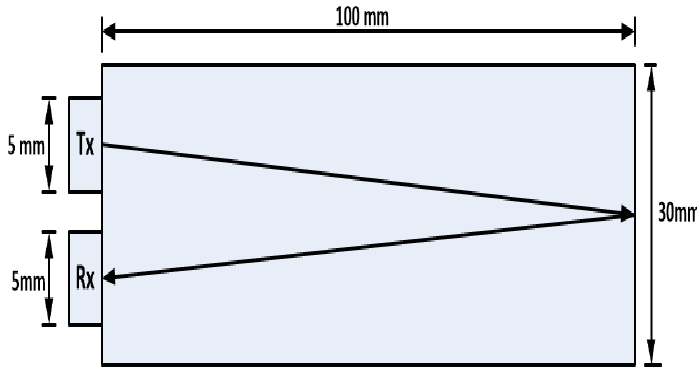
Figure 4: Schematic of the proposed method for detection of gas leakage